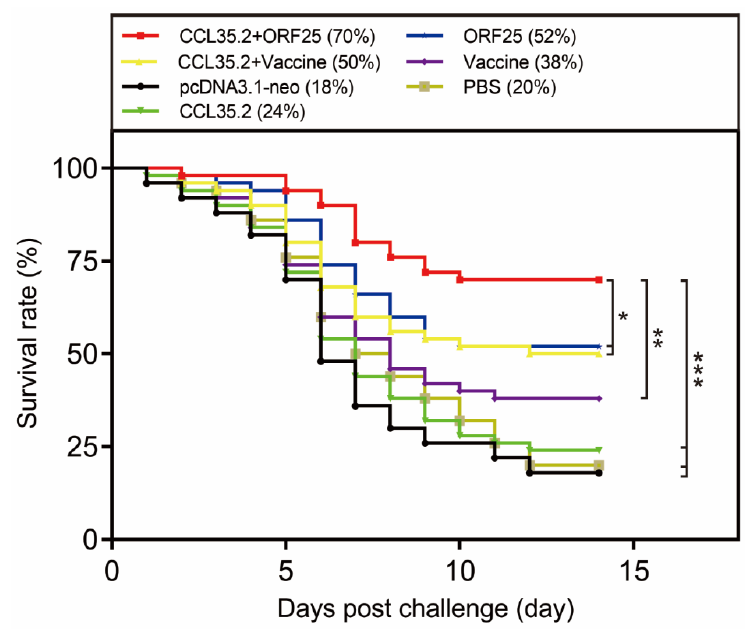
Figure 3. Survival rates of gibel carp against CyHV-2 infection. Animals were intramuscularly injected with pcORF25, pcCCL35.2/pcORF25, pcCCL35.2/Vaccine, Vaccine, pcCCL35.2, pcDNA3.1-neo, PBS